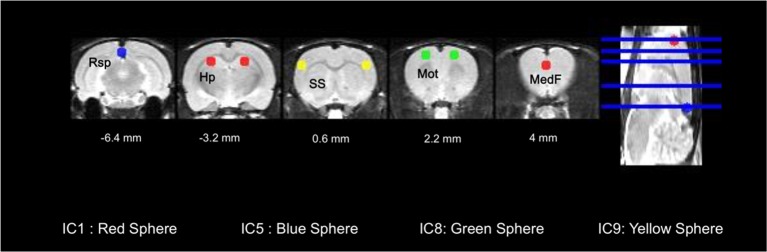
Eight volume-of-interests (VOIs) were defined as spheres with a radius of 0.8 mm (actual size), located on each of independent components (ICs).Red spheres are VOIs of IC1, blue sphere is VOIs of IC5, green spheres and yellow spheres are VOIs of IC8 and IC9, respectively. Metabolic activity of the VOIs was measured, and correlations of them per each group of rats of each age were analyzed to yield metabolic connectivity.